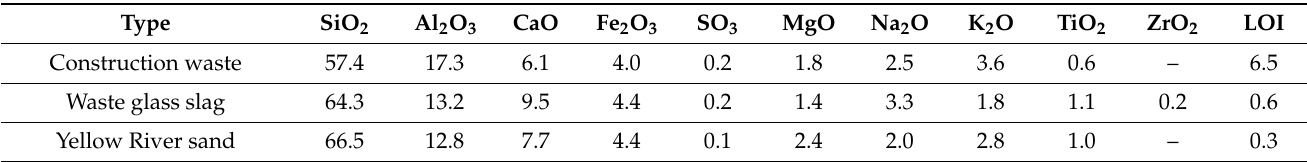
Figure 1. XRD analysis and prepared brick. ( a ) Construction waste and clay. ( b ) Yellow River sand. ( c ) Prepared brick. Table 5. XRF analysis